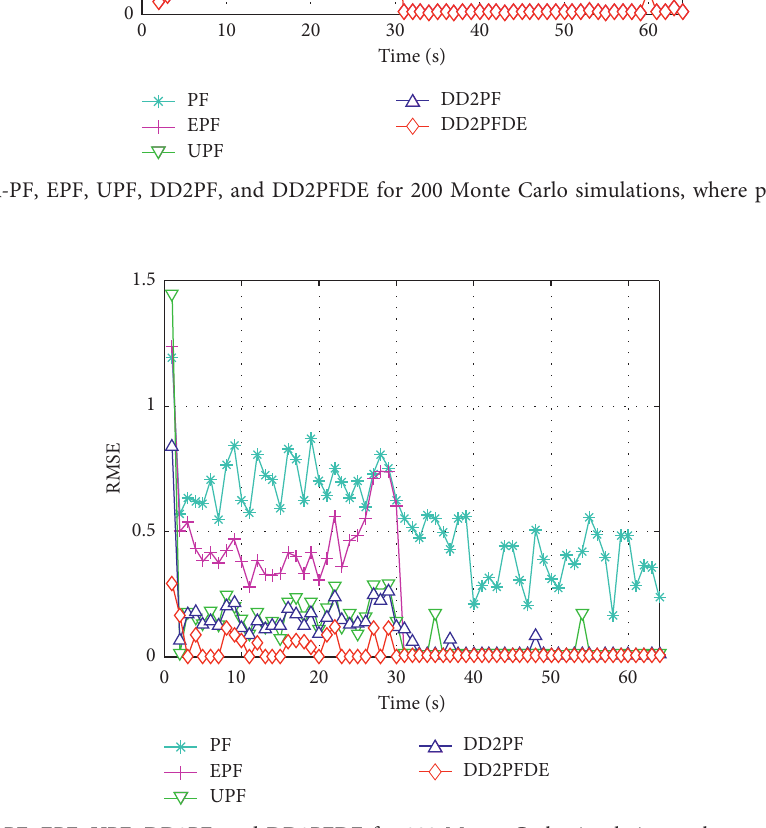
Figure 5: RMSE of SIR-PF, EPF, UPF, DD2PF, and DD2PFDE for 200 Monte Carlo simulations, where particle numbers N � 200. Table 1: Estimation results and computation times averaged over 200 Monte Carlo